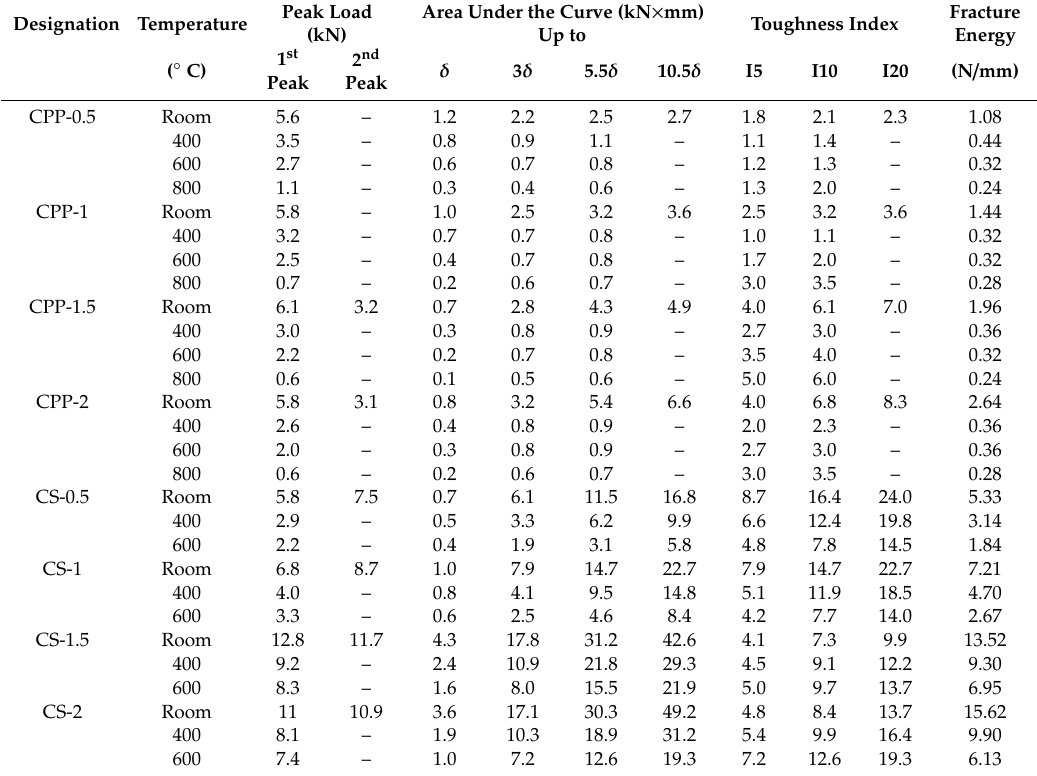
Table 5. Peak loads, flexural toughness parameters, and fracture